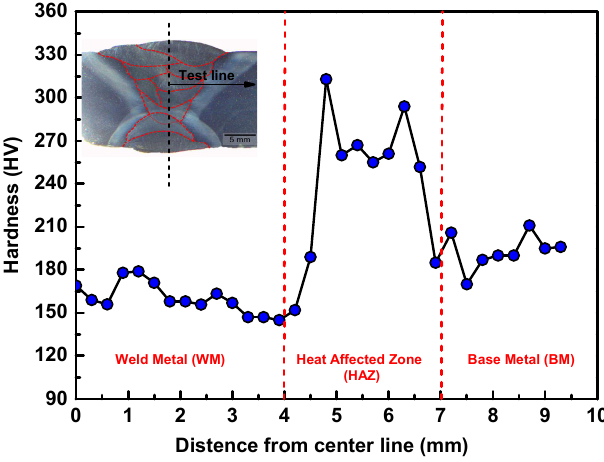
Figure 4. Microhardness profile of the welded joint.